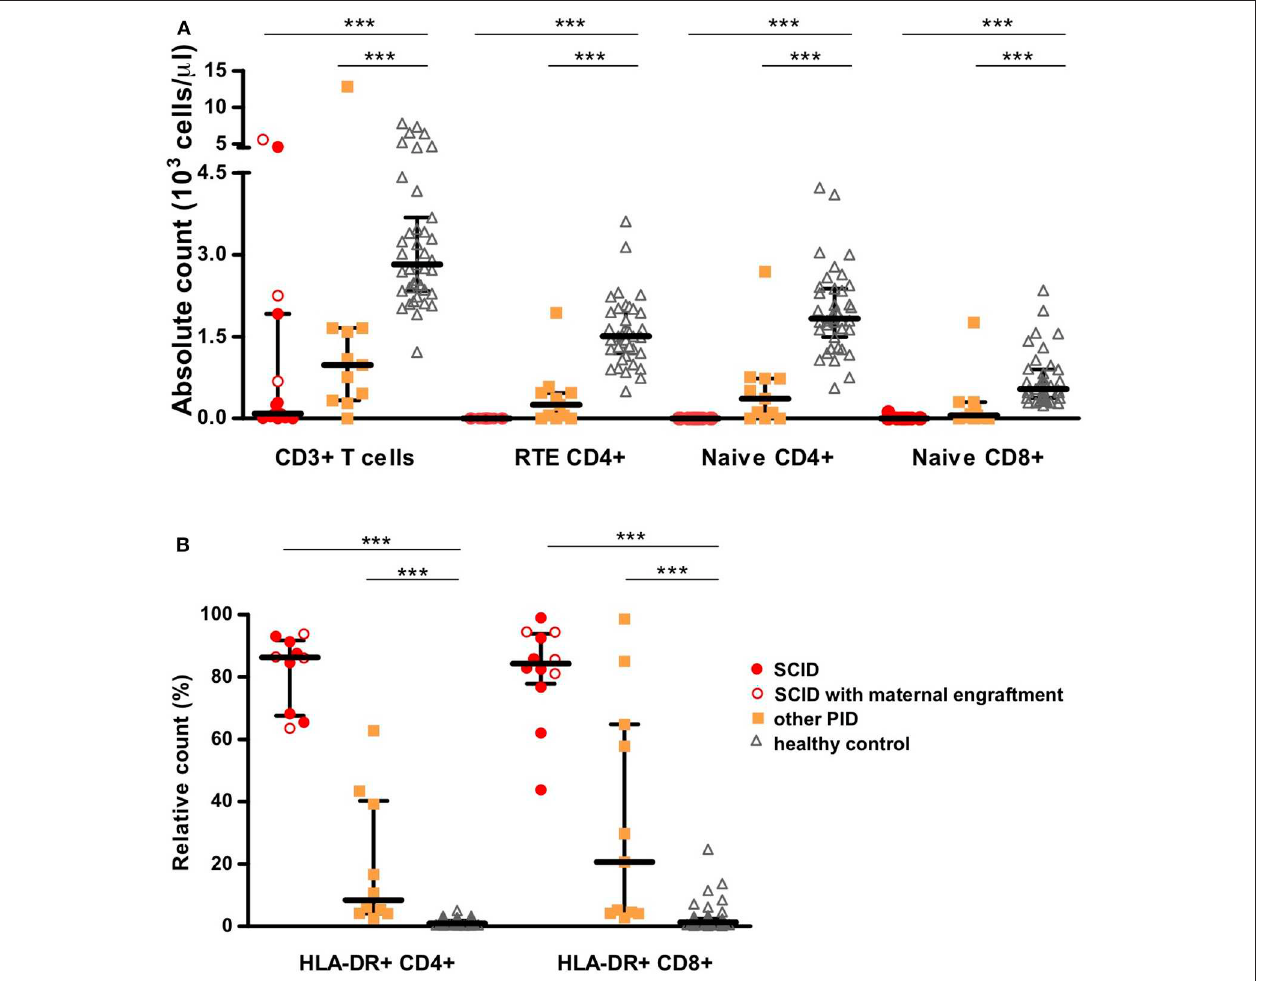
FIGURE 4 | T-cell subset counts determined using the EuroFlow SCID-RTE tube. (A) Absolute values of CD3 + T-cells, RTE CD4 + cells, naïve CD4 + or CD8 + T-cells. (B) Relative values of activated T-cells based on the expression of HLA-DR molecule on CD4 + T-cells (HLA-DR + CD4 + ) or CD8 + T-cells (HLA-DR + CD4 + ). SCID patients ( n = 15) are represented as red circles where open circles show patients with maternal engraftment, other PID patients ( n = 11) as orange squares and healthy controls ( n = 44) as gray triangles. Detailed gating strategy is shown in Supplemental Figure 1 . *** P ≤